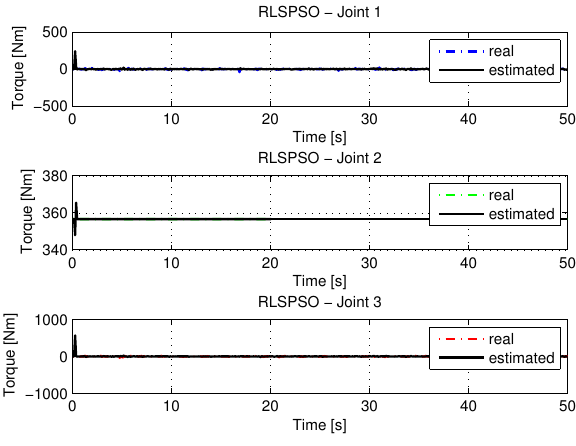
Figure 37. Torque of joints with RLSPSO with